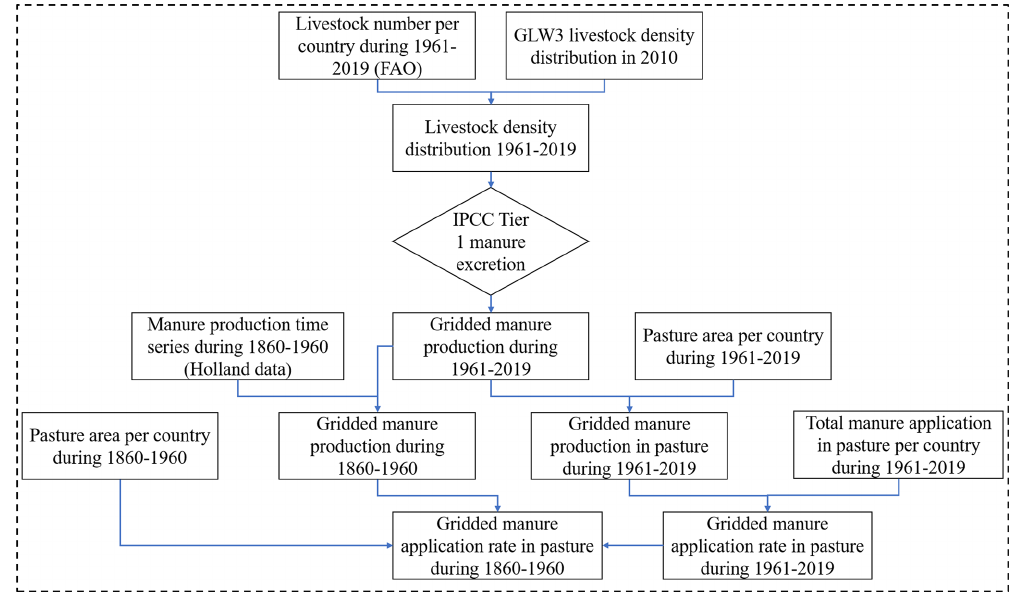
Figure 3. The workflow for developing the global pasture manure application rate data for the period from 1860 to 2019.